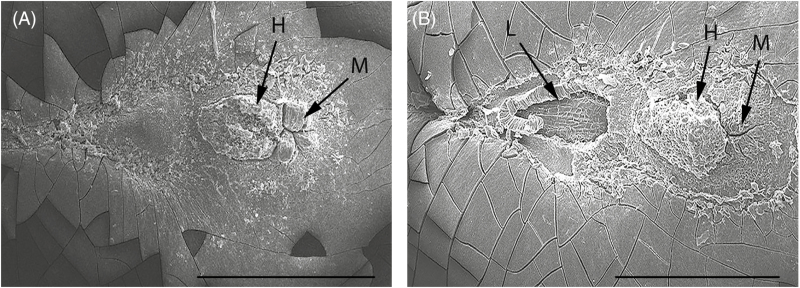
Scanning electron micrographs of (A) dormant and (B) non-dormant seeds showing the hilar side of the seeds. H, hilum; L, lens; M, micropyle. Scale: 700 µm.